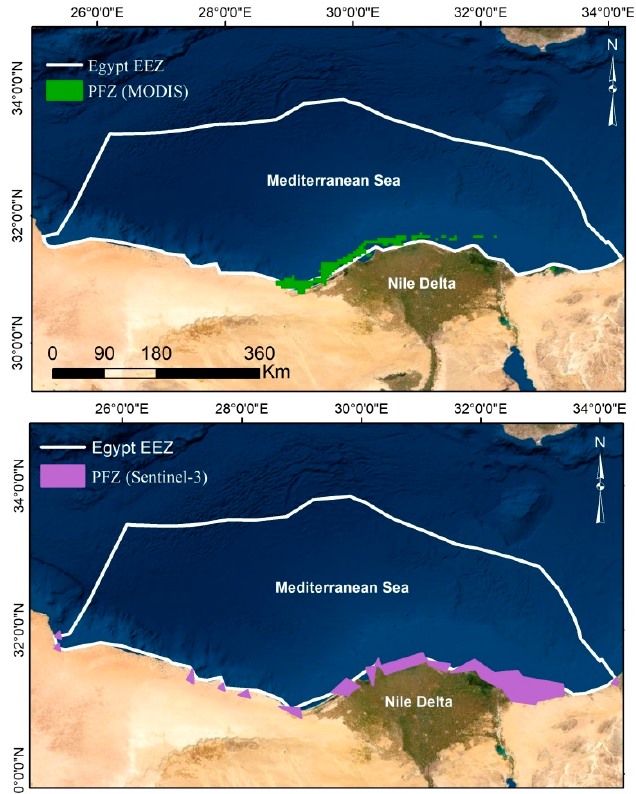
Figure 13. Spatial distribution of S. aurita PFZs on 5 October 2020, both from MODIS-Aqua and Sentinel-3 sensors.